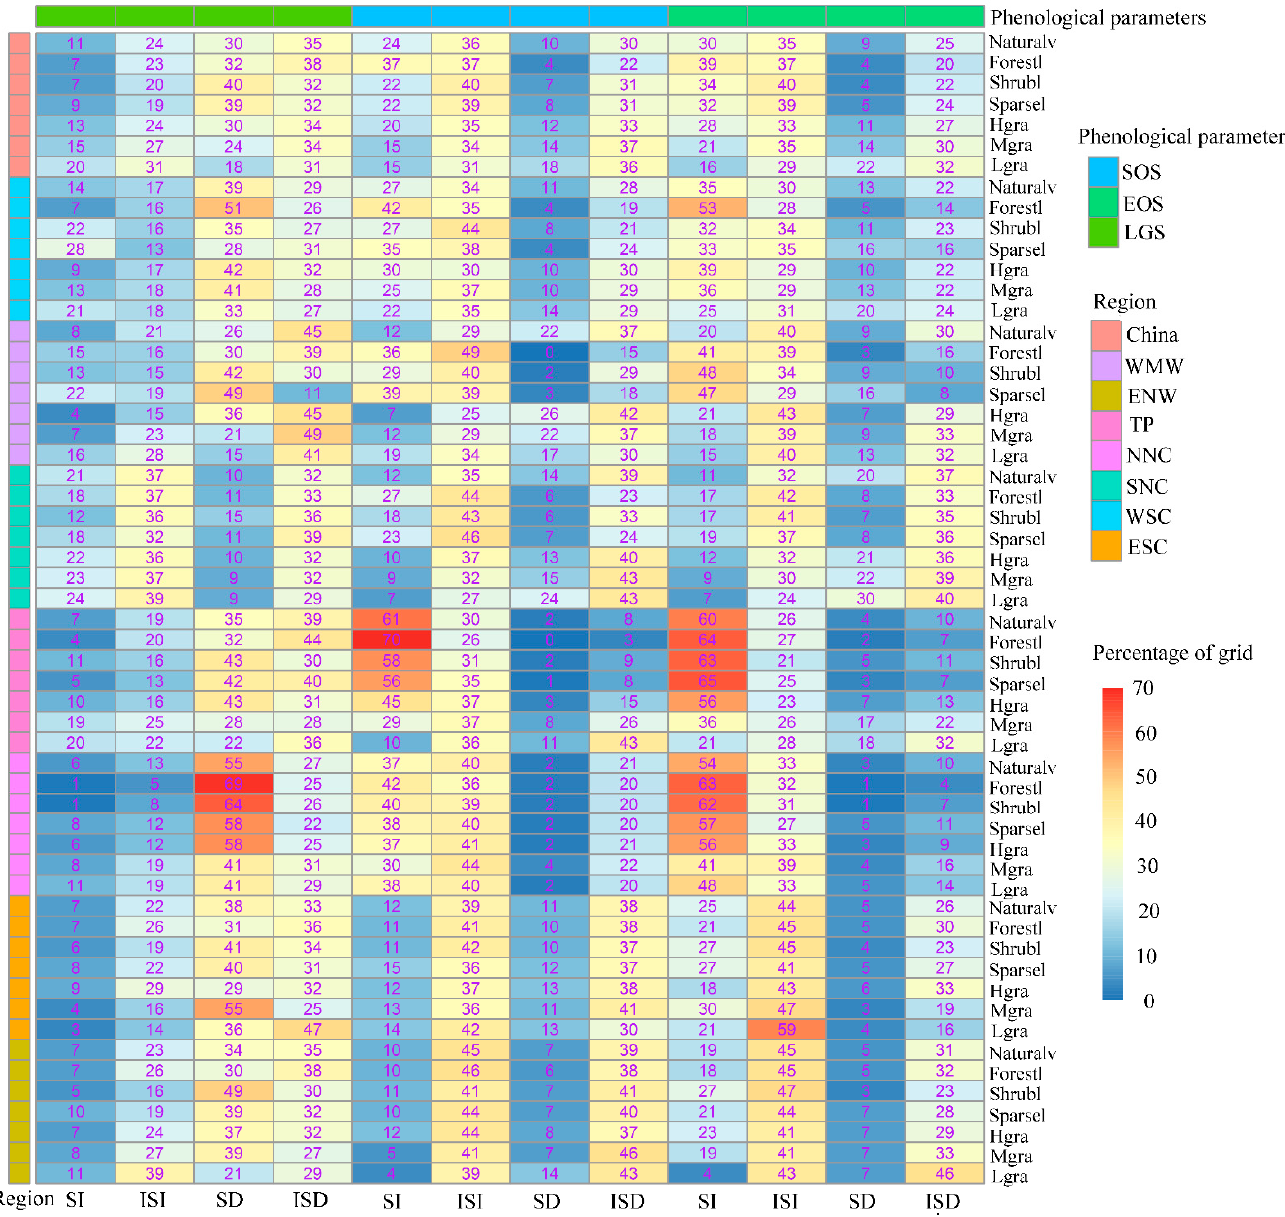
Figure 5. Percentage of grids with trends for phenological parameters (SD—significant decrease trend; ISD—insignificant decrease trend; ISI—insignificant increase trend; SI—significant increase trend. Abbreviations: Agrl—Agricultural land; Watr—Water bodies; Uril—Urban and rural land; Bald—Unutilized land; Forestl—Forest land; Shrubl—Shrubland; Sparsel—Sparse forest land; Hgra—High coverage grassland; Mgra—Medium coverage grassland; Lgra—Low coverage grassland; Snga—Permanent snow and glacier; WNW—Western arid and semi-arid region; ENW—Eastern arid and semi-arid region; TP—Qinghai-Tibet alpine region; NNC—Northern North China; SNC—Southern North China; WSC—Western South China; ESC—Eastern South